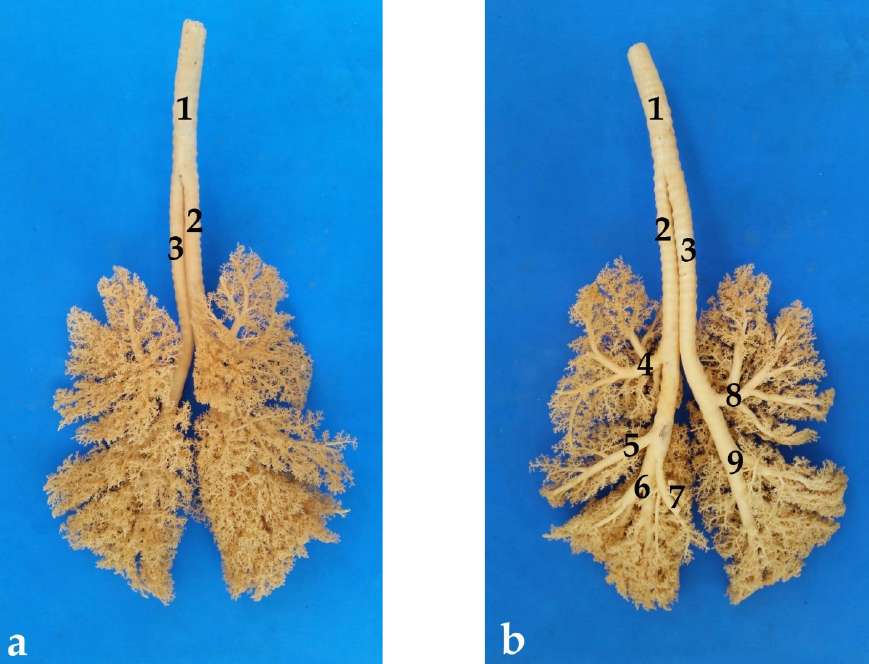
Figure 8. Polyurethane bronchial tree: ( a ) dorsal view; ( b ) ventral view; (1) trachea; (2) right main bronchus; (3) left main bronchus; (4) right cranial lobar bronchus; (5) right mid lobar bronchus; (6) right caudal lobar bronchus; (7) accessory lobar bronchus; (8) left cranial lobar bronchus; (9) left caudal lobar bronchus. After traveling about 8 cm in juveniles and about 14 cm in adults, a second bronchial branch emerges. It is the right cranial lobar bronchus, which ventilates the cranial lobe of the right lung. This right main bronchus continues traveling about 5 cm more, inside the thoracic cavity, until the lung hilus, where the other three branches of the right main bron- chus arise almost simultaneously. The first of these three branches is the so-called right middle lobar bronchus, which ventilates the middle lobe of the right lung. This bronchus extends throughout the entire middle lobe, branching into several collateral bronchi ( bronchi segmentalis ). Immediately after the right middle lobar bronchus, the caudal right lobar bronchus emerges, which ventilates the caudal right lobe. The right accessory lobar bronchus appears practically at the same level, which enters the accessory lobe of the right lung. The left main bronchus gives rise only to two branches, both located at the level of the pulmonary hilus. This second left bronchial generation arises to about 11 cm from the tracheal bifurcation in juveniles and approximately 16 cm in adults, cranially to the triple branching of the right main bronchus. The left main bronchus branches into two second- ary bronchi: the left cranial bronchus and the left caudal bronchus. The left cranial